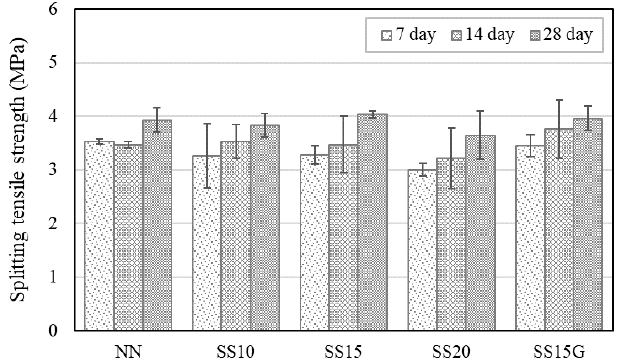
Figure 7. Test results of splitting tensile strength at three di ff erent time points.